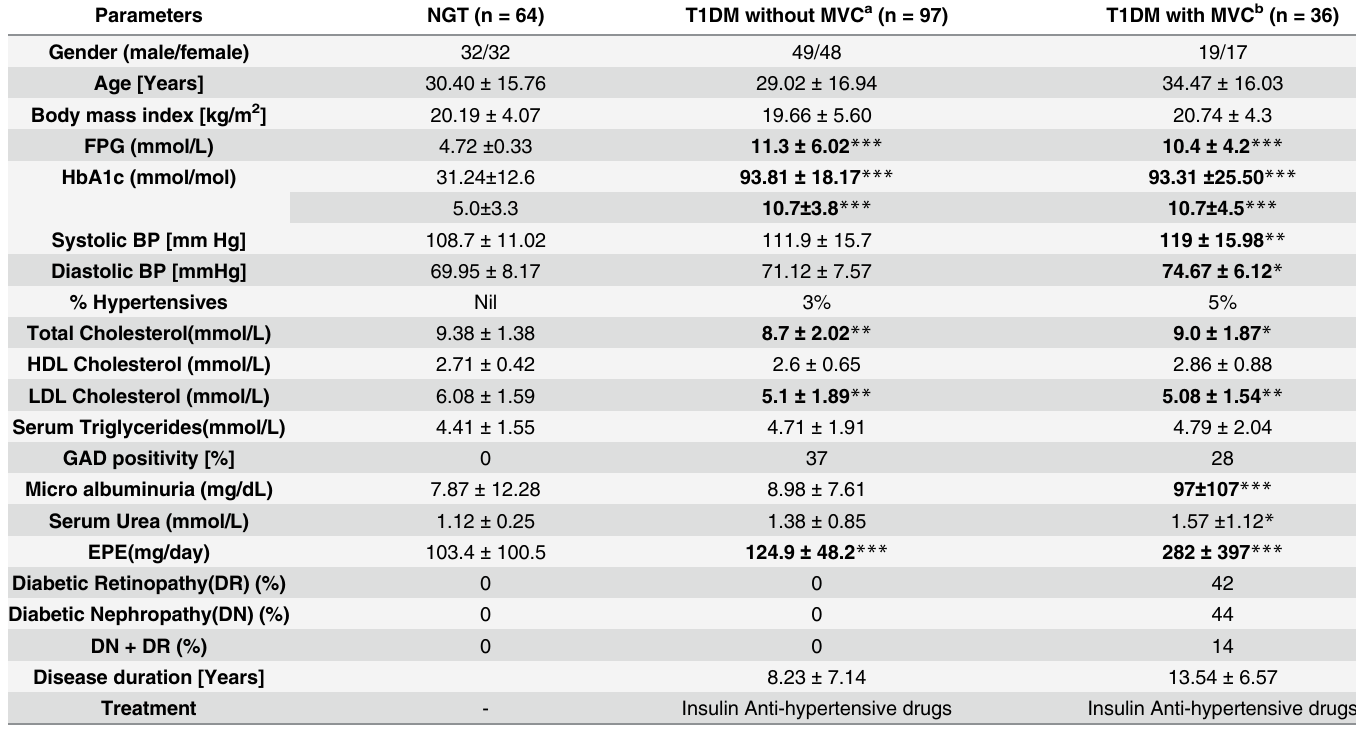
Table 1. Clinical characteristics of the study